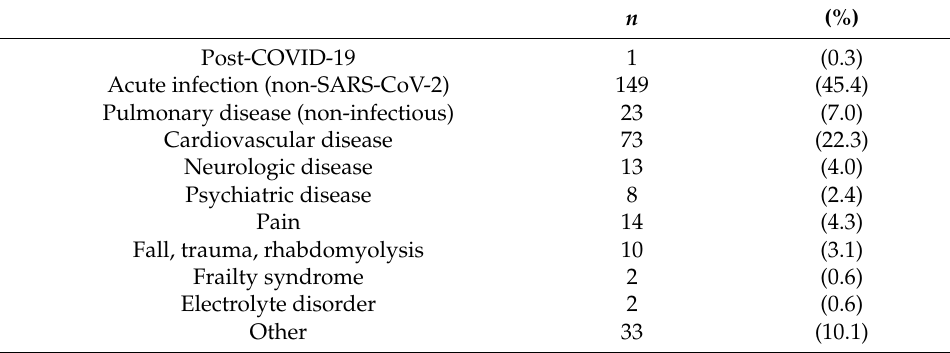
Table A2. Groups of final diagnoses of all 328 patients with suspected COVID-19 and subsequent negative SARS-CoV-2-PCR swab